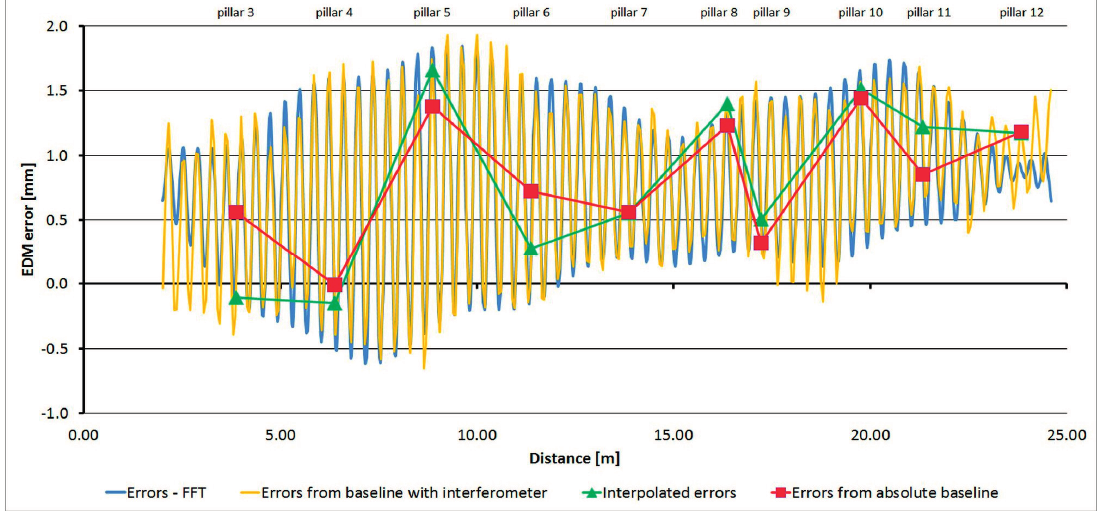
Figure 32. The resulting graph of the combination of absolute and relative errors and the correcting function by FFT–Trimble S6.